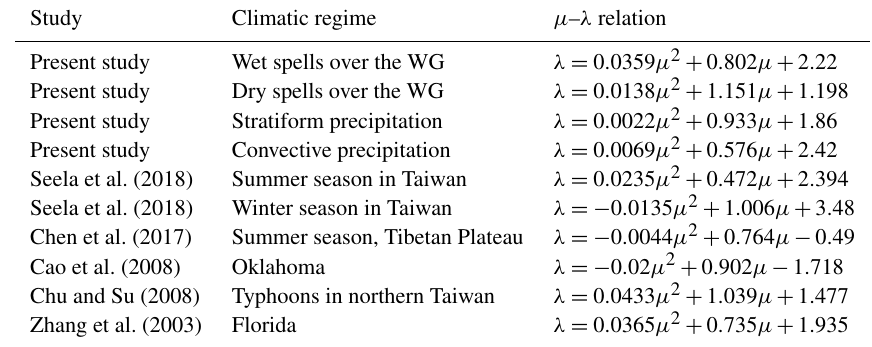
Figure 13. Summary of DSD characteristics for wet and dry spells in the WG region. Table 5. Comparison of µ – λ relations derived in the present study with other orographic precipitation